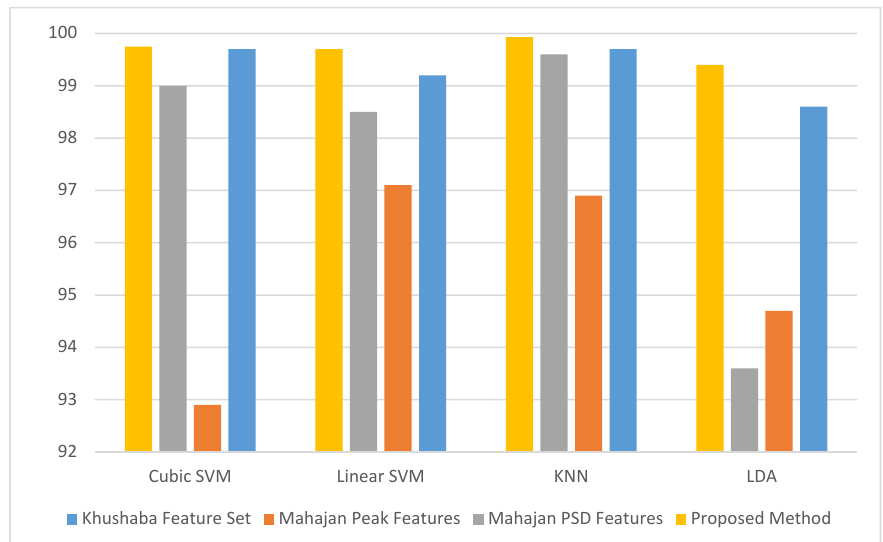
Figure 14. The classification accuracy of detecting stress and non-stress states using our proposed Feature-Set 3 compared to Khushaba et al. [22] and the two feature-sets from Mahajan [18] using only Fp1 + Fp2 frontal electrodes.